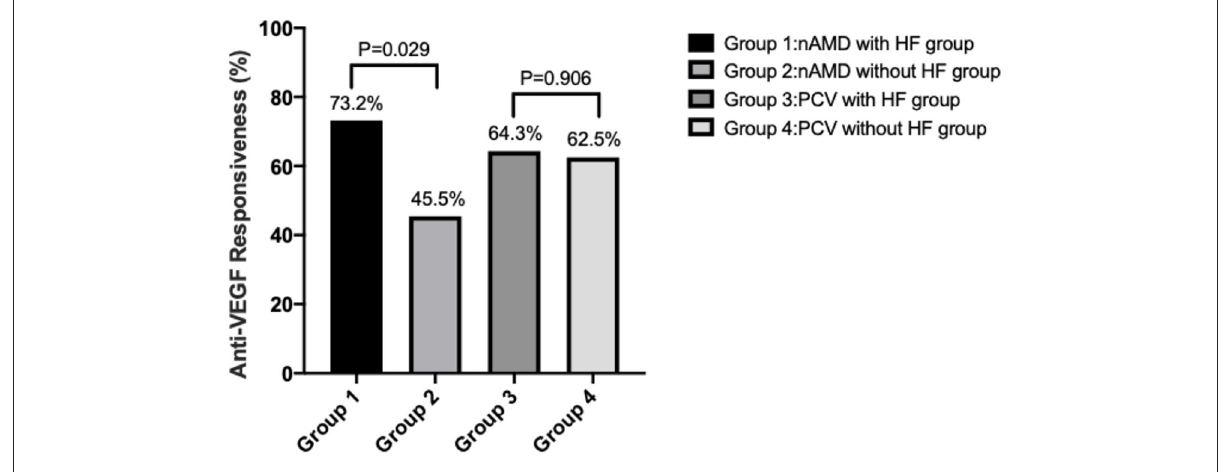
FIGURE2 Sensitivity rate of anti-VEGF therapy in eyes with or without HF in the nAMD and PCV groups. Anti-VEGF responsiveness was calculated by CMT reduction_ratio